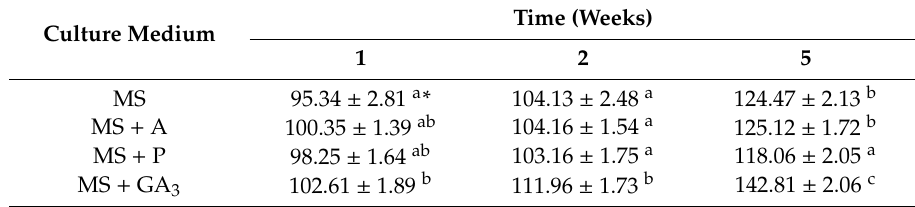
Table 1. E ff ect of gibberellic acid (GA 3 ) and gibberellin biosynthesis (GA) inhibitors (10 µ M): ancymidol (A) and paclobutrazol (P) on bulb fresh weight (mg) cultured for 1, 2 and 5 weeks at 24 ◦ C.